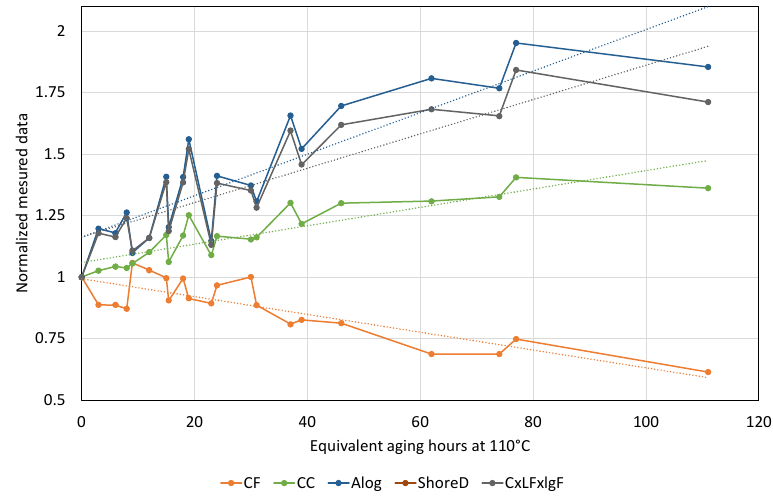
Figure 9. Deducted quantities with the highest correlation coefficients for following aging at 110 °C. The dashed lines are the corresponding linear regression lines of a given deducted quantity.